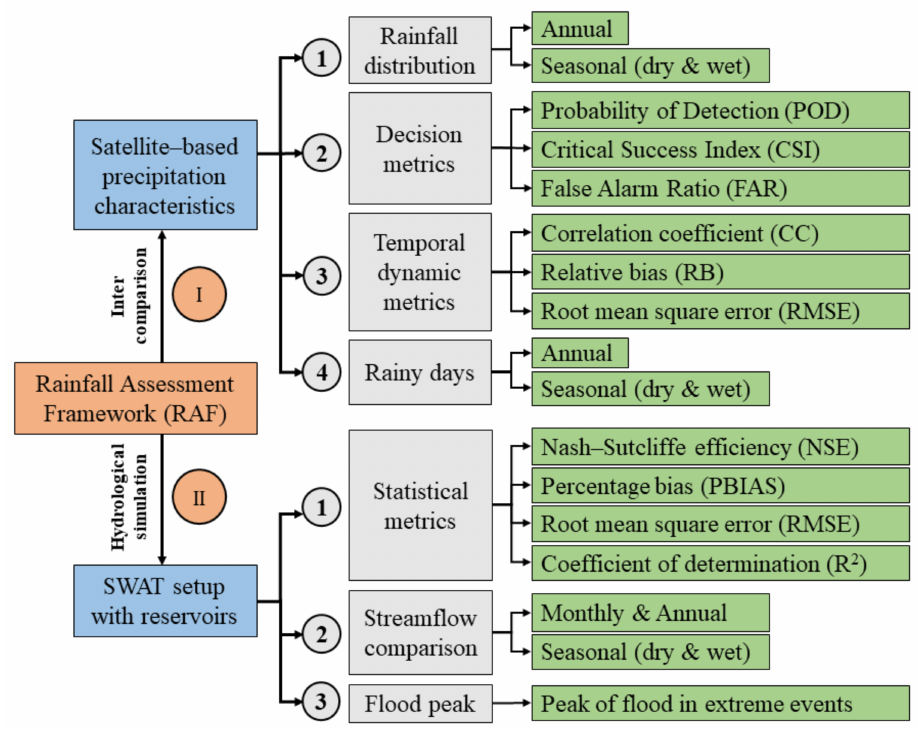
Figure 2. Flowchart of the Rainfall Assessment Framework (RAF). The number represents the order of assessment stages performed throughout this